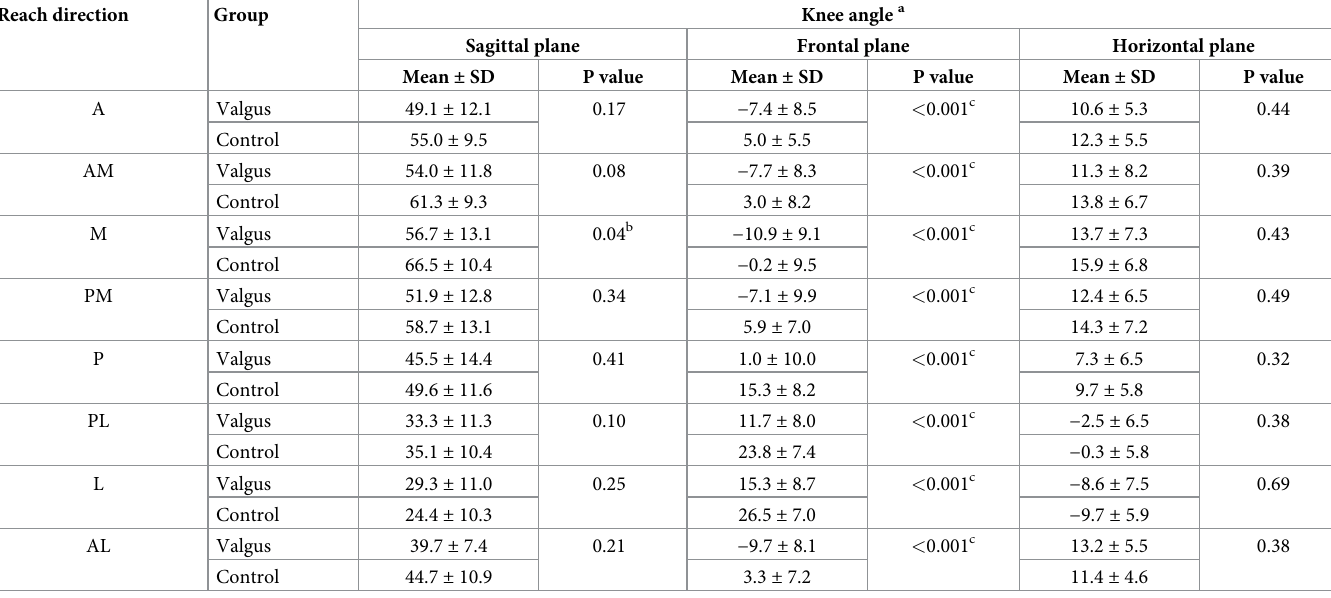
Table 2. The results of knee angle (mean ± SD, deg) in all reach directions during Star Excursion Balance Test. Reach